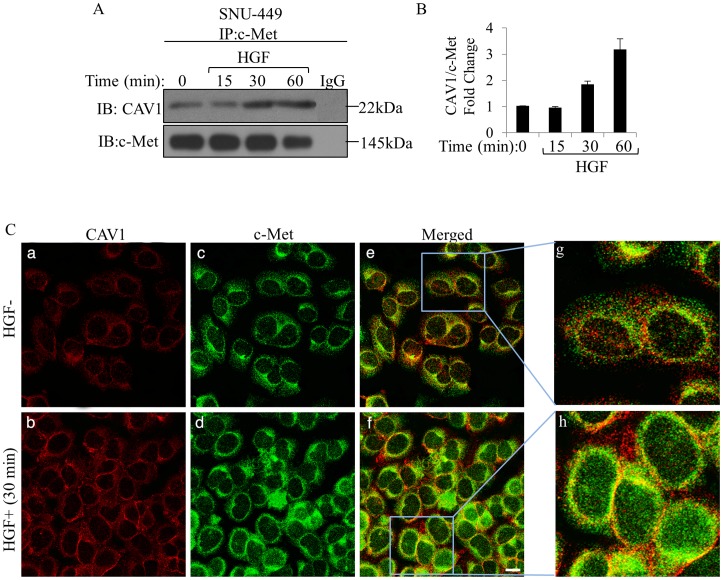

A. HGF induced association of CAV1 with c-Met. Serum starved SNU-449 cells were exposed to HGF for 15, 30 and 60 min. Whole cell lysates were immunoprecipitated with anti-c-Met antibody, resolved by SDS-PAGE and immunoblotted with antibody to CAV1 and c-Met. Anti-c-Met antibody was probed to the membrane as a loading control. There was no detectable c-Met and CAV1 band in immunoprecipitates prepared with IgG as an IP-control. B. The relative CAV1 intensities for the different treatments relative to the corresponding levels of c-Met were calculated. Different treatments relative to the present in the untreated control sample are compared in the bar graphs. Data were expressed as mean ± standard error (SE) of three independently experiments. C. Overnight starved SNU-449 cells were treated without (upper row)/with HGF (lower row) for 60 min. Representative image showing protein expression by double CM of CAV1 (red, Alexa 455) 1 (a, b), c-Met (green, Alexa 488) (c, d). Overlapping of red and green signals shown in yellow indicate the co-localization of the two proteins (e, f). Nuclei were stained with DAPI (blue). Blue boxed areas were enlarged in the insets to reveal the incidence of colocalization (g, h). Scale bar: 200 µm.